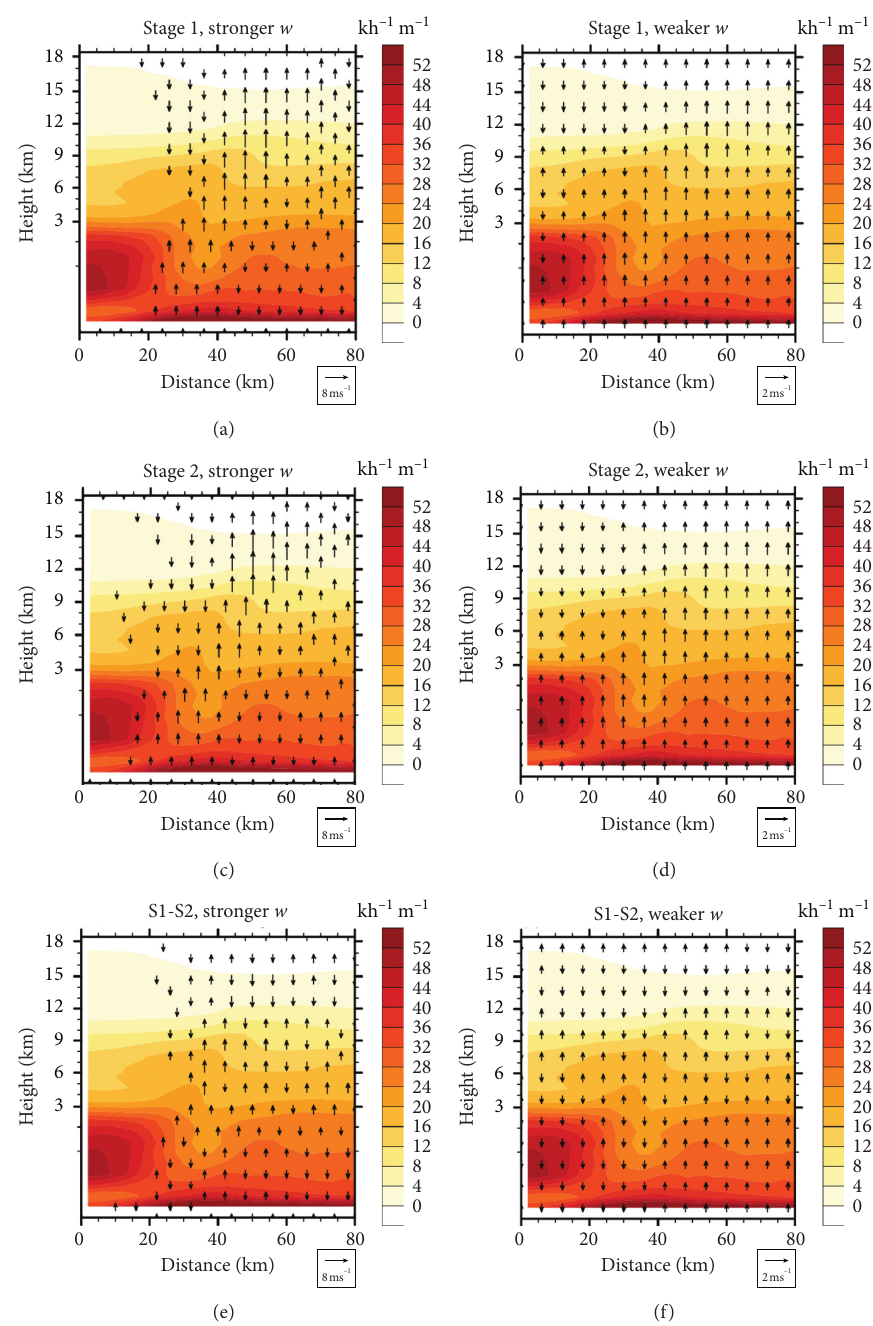
Figure 14: Variation of the azimuthally averaged remaining thermodynamic terms of LH from vertical advection except w ( − ( θ T · z q / z z in equation (2); shading) with the radius and height of w (vectors). (a, c, e) The velocities with absolute values above the threshold v ) defined in Section 3.3. (b, d, f) The velocities with absolute values below the